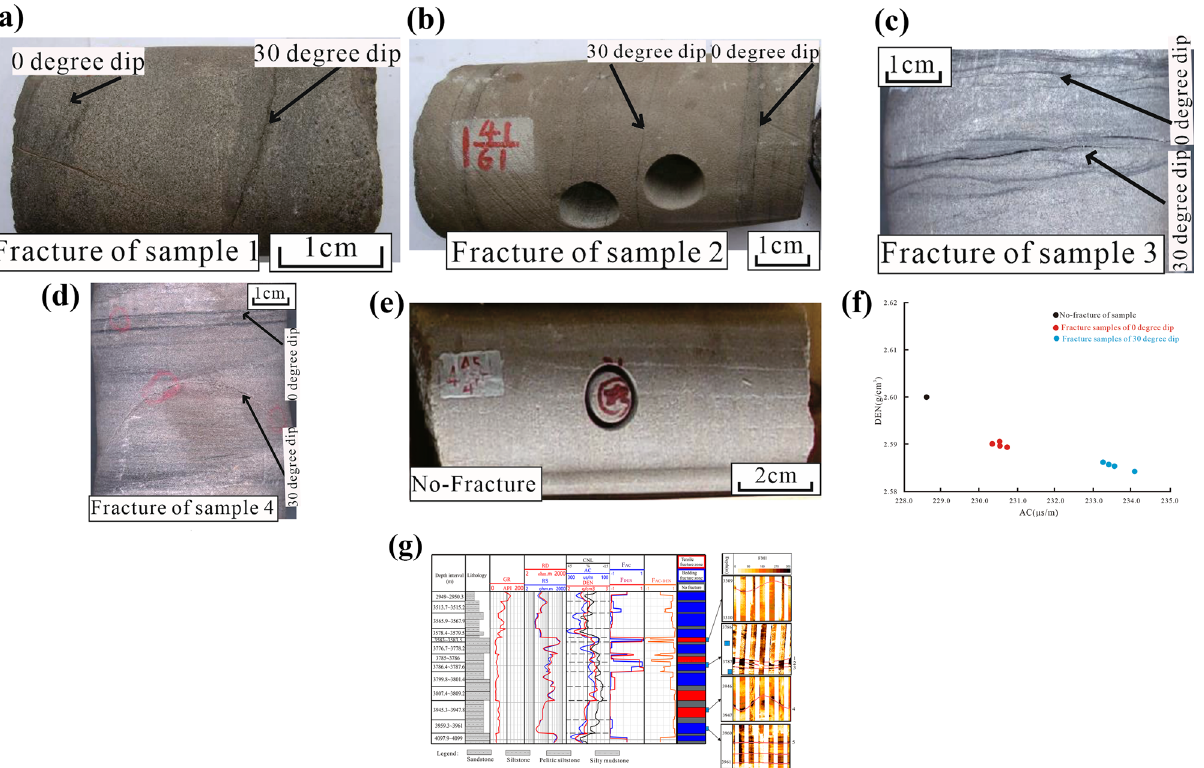
Figure 6. Core sample and actual log response characteristics of non-fractured rock and different dip fractures. ( a ) Fracture of sample 1. ( b ) Fracture of sample 2. ( c ) Fracture of sample 3. ( d ) Fracture of sample 4. ( e ) Non- fractured sample. ( f ) Acoustic-density response characteristic intersection diagram for fractures and non-fractures. ( g ) The red area is the tension fracture development zone, the blue area is the bedding fracture development zone, and the gray area is the intact zone. F AC is the AC correlation coefficient, F DEN is the DEN correlation coefficient, and F AC-DEN is the AC-DEN correlation coefficient (compared with imaging results), showing that F AC-DEN can adequately identify fracture zones. FMI is Formation MicroScanner Image.